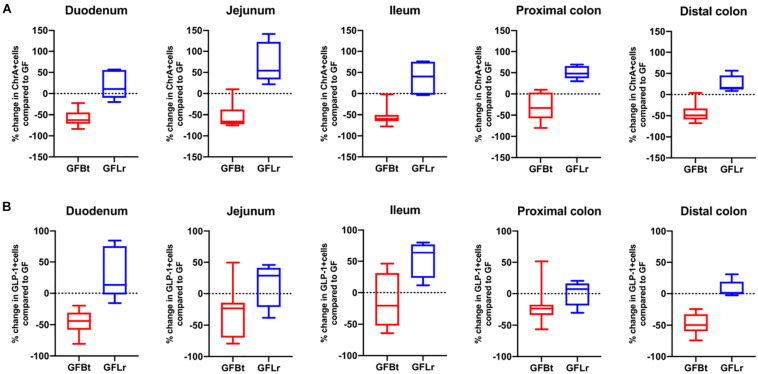
The effect of Bt on ChrA and GLP-1 EECs is not replicated with another gut commensal bacterium. (A) Percentage change of ChrA+
(A) or GLP-1+
(B) EECs throughout the GIT of GF mice after mono-colonization with Bt (GFBt, n=10) or Lactobaccillus reuteri (GFLr, n=5) compared to the number of GIP+ cells in GF (n=11) mice, which is shown as a dashed horizontal line and is set at zero. The box of the box whisker plots extends from the 25th to 75th percentiles with the horizontal line within the box representing the median and the whiskers representing the minimum and maximum values.